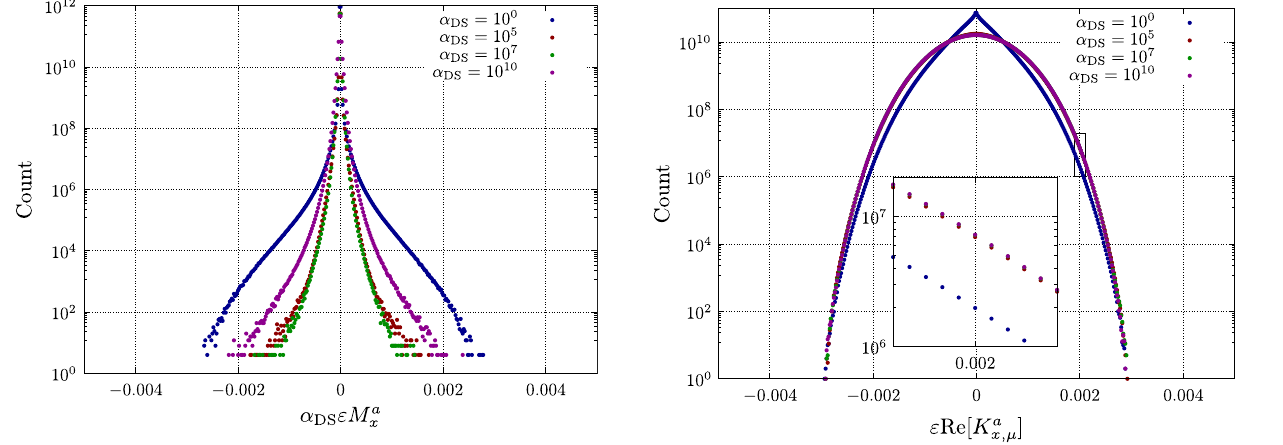
Fig. 9 Histogram of the real part of the Langevin drift, i.e. Eq. (19), multiplied by the Langevin step size, for different values of the DS control parameter α